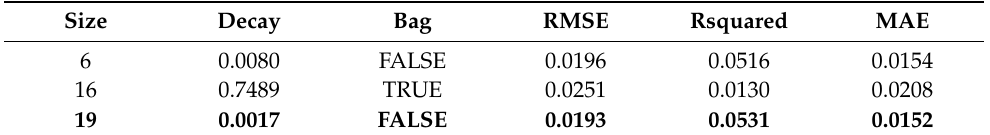
Table 1. Model averaged neural network.